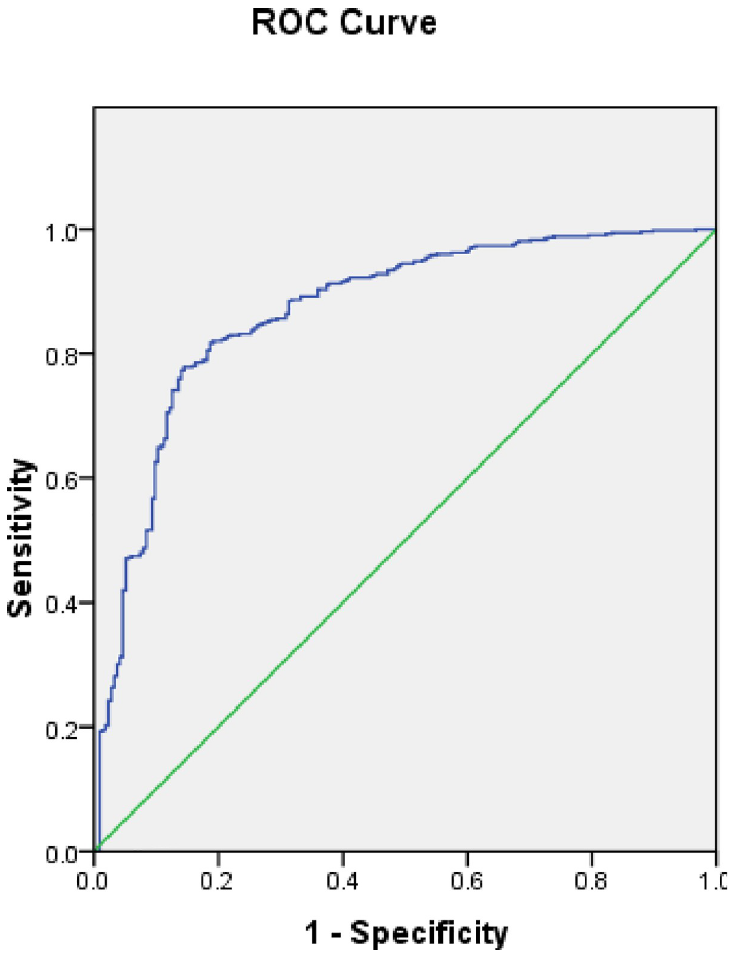
Fig 13. Receiver operator characteristic (ROC) curve based on data from April 10, 2020.